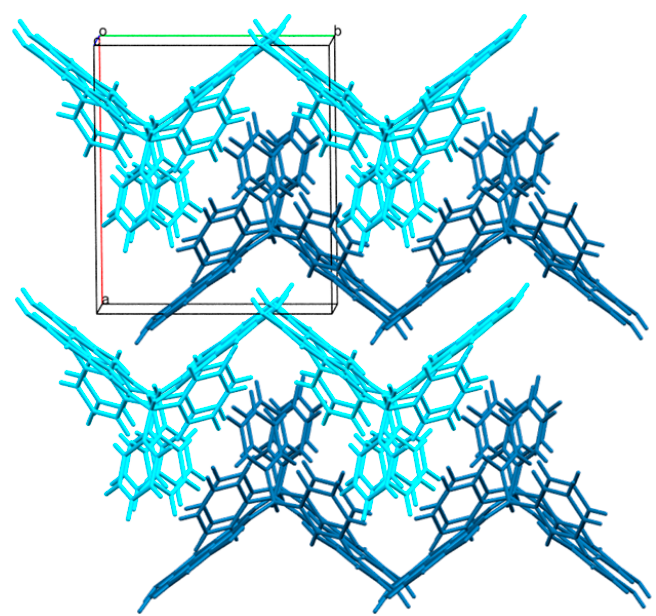
Figure B4. Packing diagram for mOHsaladpm .